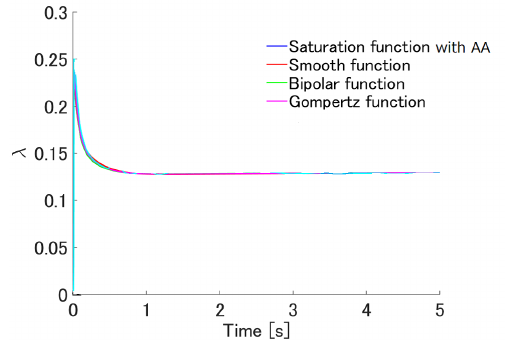
Figure 10. Time response of driving torque on dry asphalt